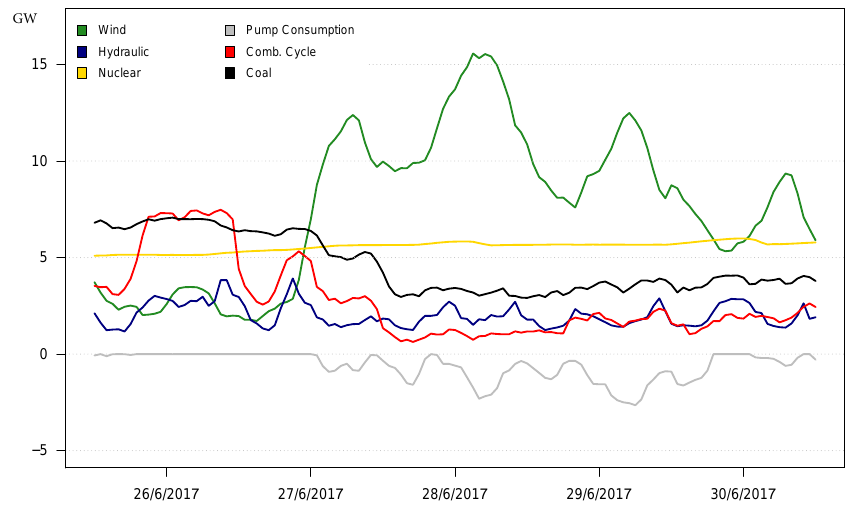
Figure 8. A high VRES period in June 2017. Source: authors based on the REE data [11].